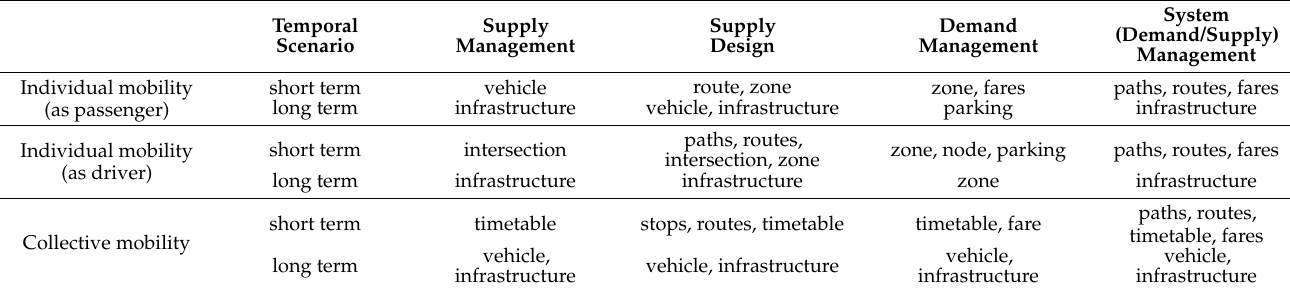
Table 2. Evaluation methods (ii) for transport system component design in relation to passenger